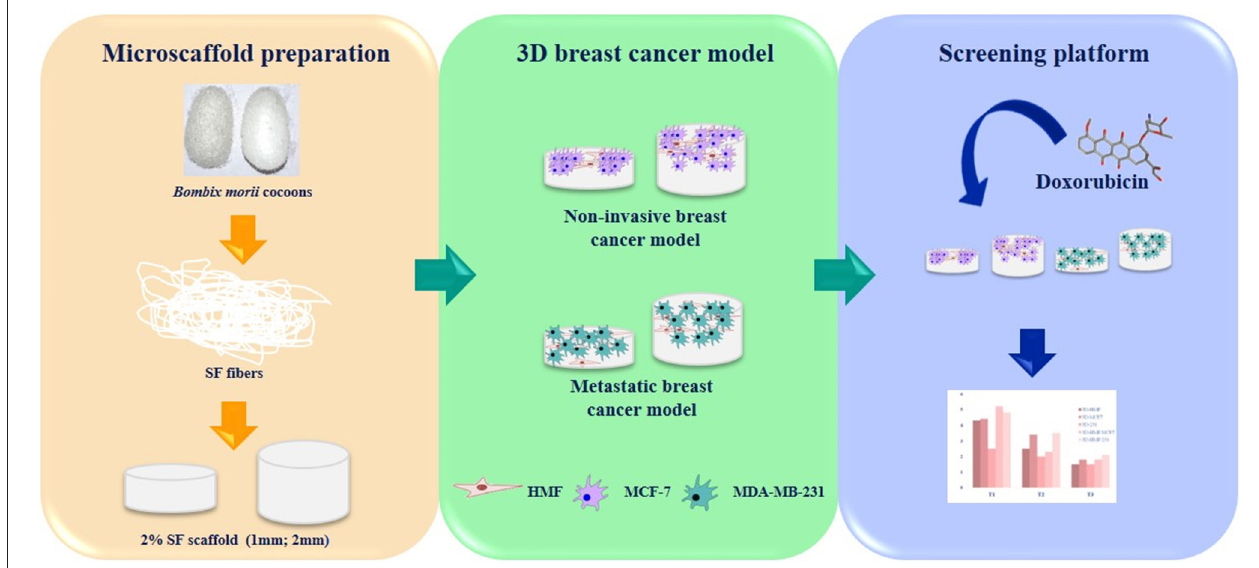
FIGURE 8 | Graphical summary of the experimental setting. Silk fibroin scaffolds are used as matrix to grow different breast cancer cells lines together with mammary fibroblast. The 3D tumor models are challenged with doxorubicin to demonstrate the effect of tumor - stroma cells to the drug